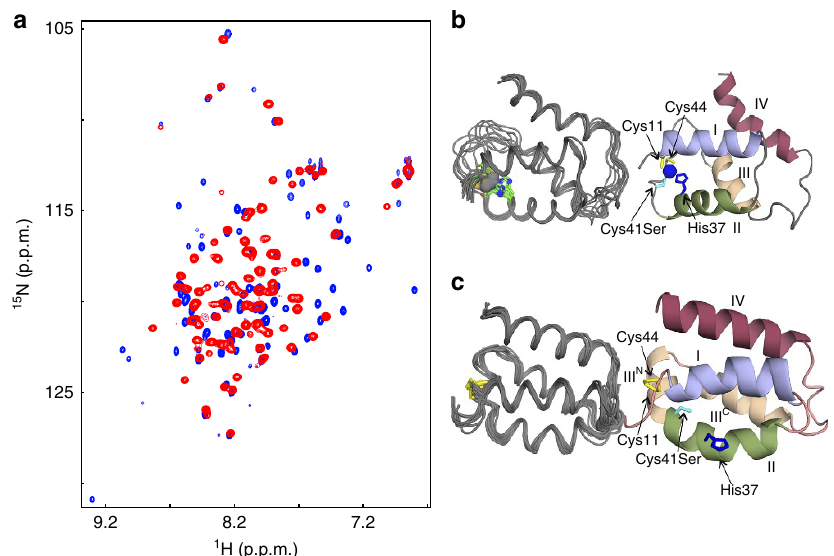
Figure 6 | Solution structures of RsrA red .Zn 2 þ and RsrA ox . ( a ) Comparison of 1 H- 15 N-HSQC spectra of reduced RsrA* Cys41Ser (RsrA red -Zn 2 þ , blue peaks), in 20mM Tris buffer (pH 7.1) containing 5mM DTTand 2mM ZnCl 2 , with RsrA ox (red peaks), which is the same protein in the same buffer but in the absence of reductant and metal ions. ( b ) Overlay of the 10 lowest-energy structures for RsrA red -Zn 2 þ (residues Glu8–Gln86; left-hand figure) and a ribbon diagram of the lowest-energy structure (right-hand figure), showing the location of the zinc-binding residues (His37, blue; Cys41Ser, cyan; Cys11 and Cys44, yellow) and the zinc atom (blue). ( c ) Overlay of the 10 lowest-energy structures for RsrA ox (residues Glu8–Gln86; left-hand figure) and a ribbon diagram of the lowest-energy structure (right-hand figure), showing the location of the disulfide bond and disruption of the metal site following oxidation (residues and helices are coloured as in b